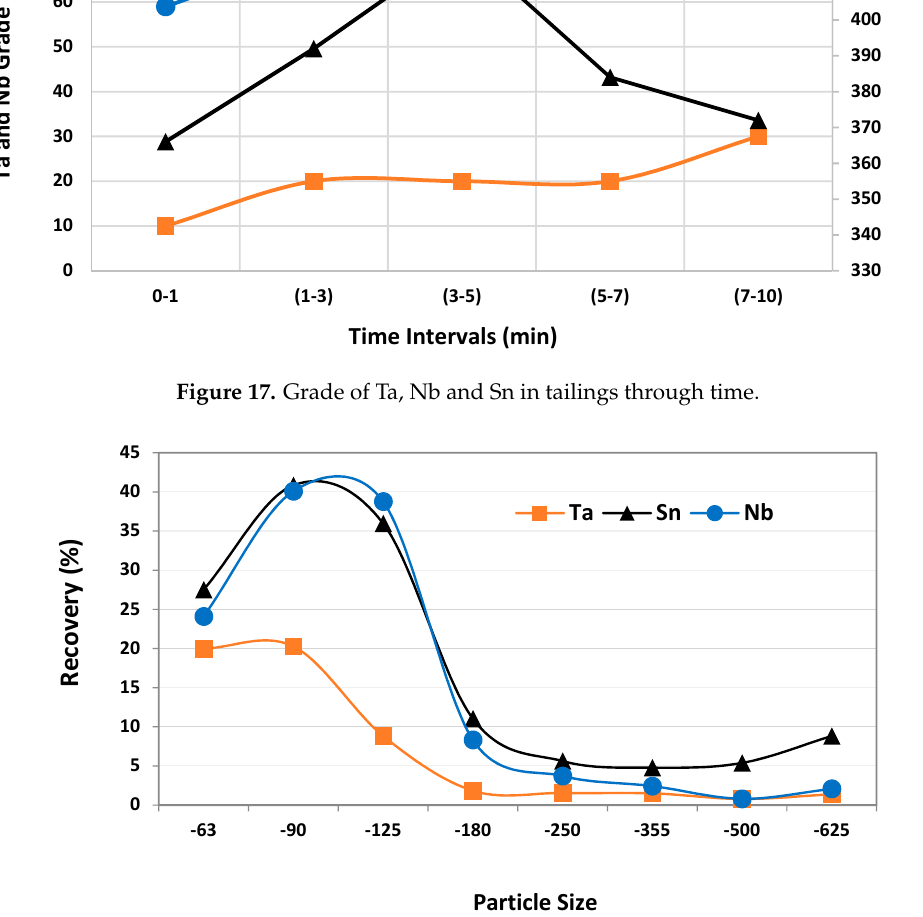
Figure 18. Average recovery by particle size during separation by a Knelson concentrator. Recoveries calculated from PXRF results.